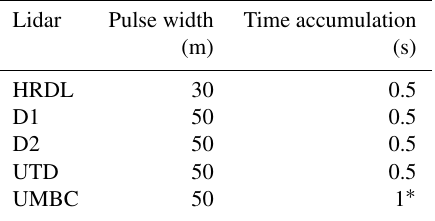
Table 3. Scan initialization delay estimates for the scanning Doppler lidars.